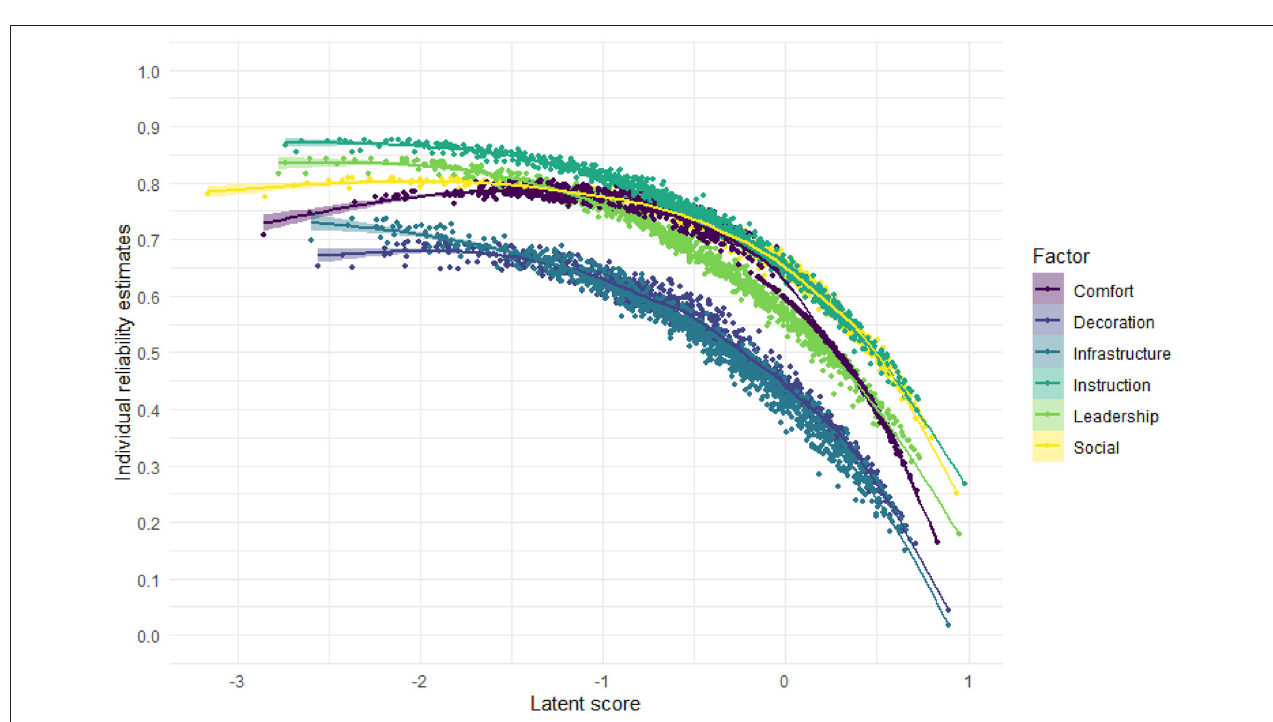
FIGURE 3 | Individual reliability estimates according to the theoretical dimensions from the multidimensional item response theory analysis of the SQAE. opted out for not being contemplated by the initial reviewed literature and the theory